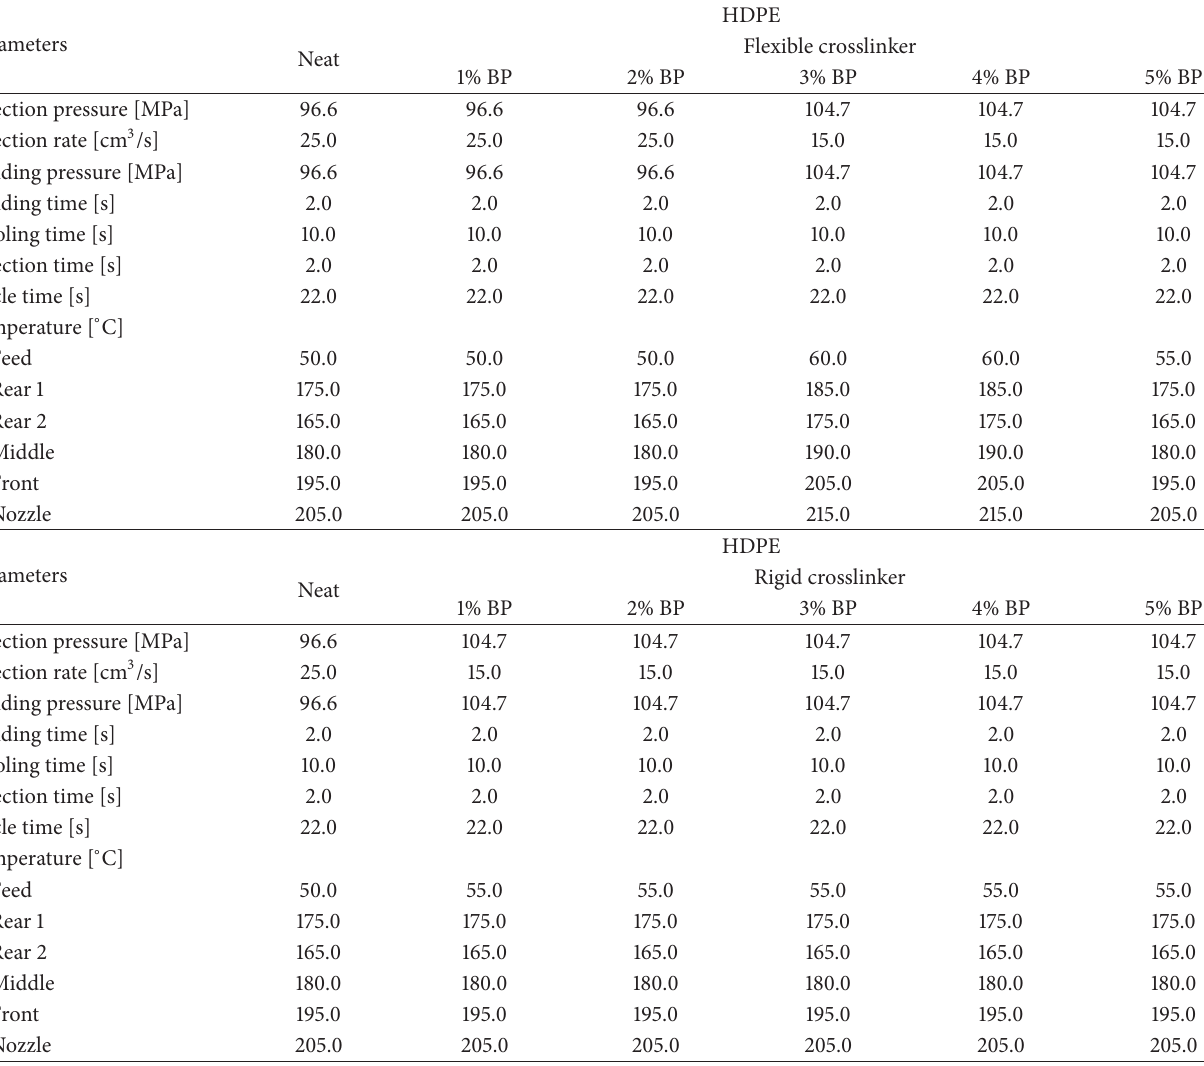
Table 3: The main injection molding parameters used for HDPE/BP compounds.